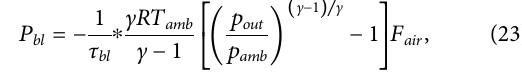
Frontiers in Energy Research |